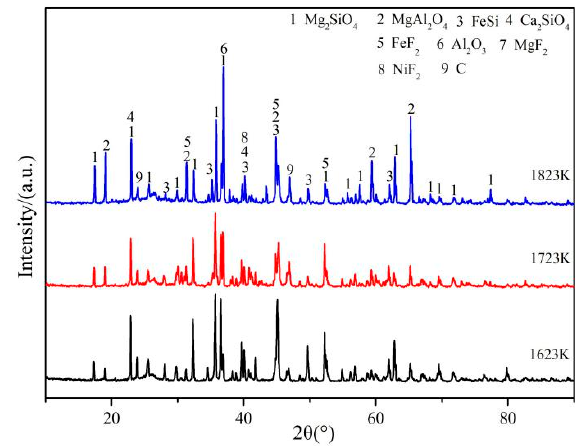
Figure 18. XRD patterns of the Fe–Ni-rich residue at different temperatures with 3% CaF 2 .